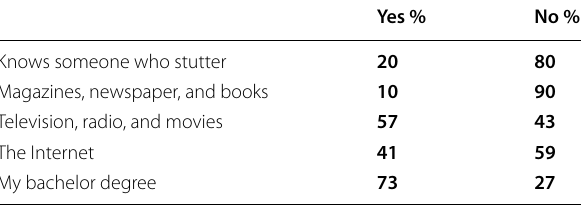
Table 8 The teachers’ sources of information about